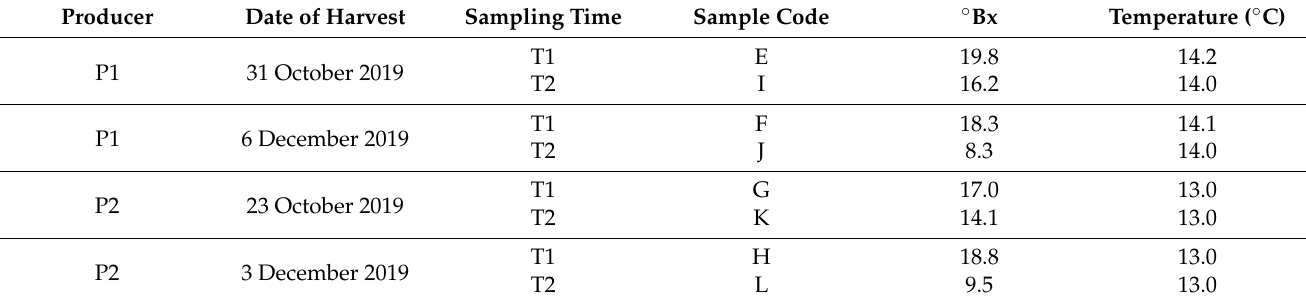
Table 4. Characterization of the fermented mass at the sampling periods (Brix degree and